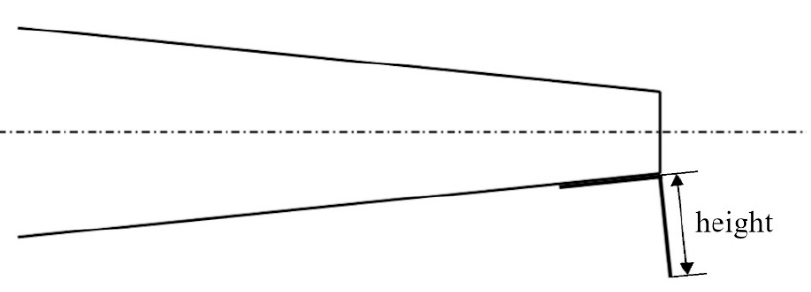
Figure 2. Experimental Gurney flap (GF) geometry. Table 1. Details of the experimental setup.